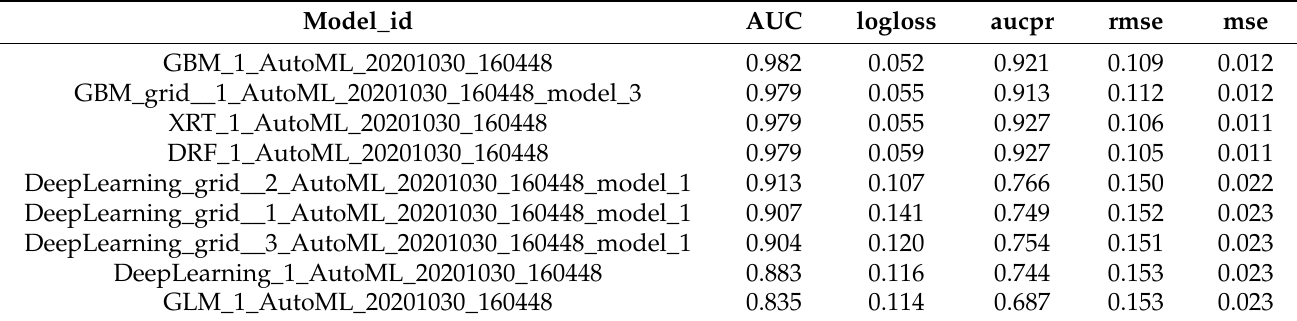
Table 6. Results of different models used to predict safety stops using the automatic machine